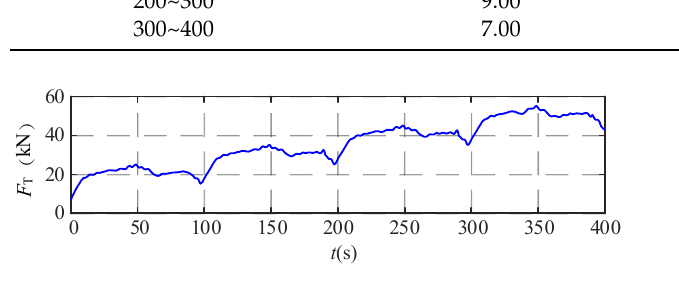
Figure 16. Ploughing cycle.